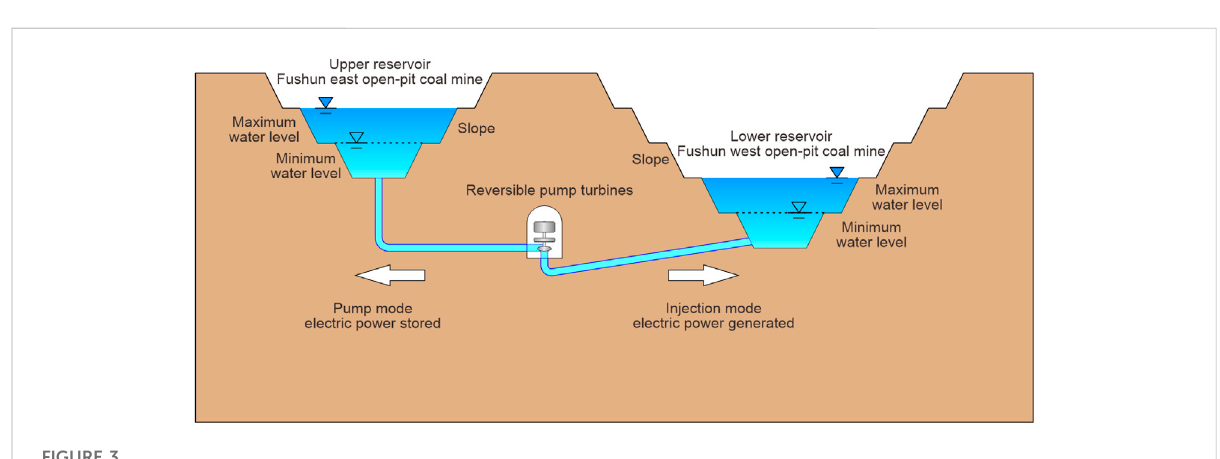
FIGURE 3 Schematic of the PSH plant in open-pit